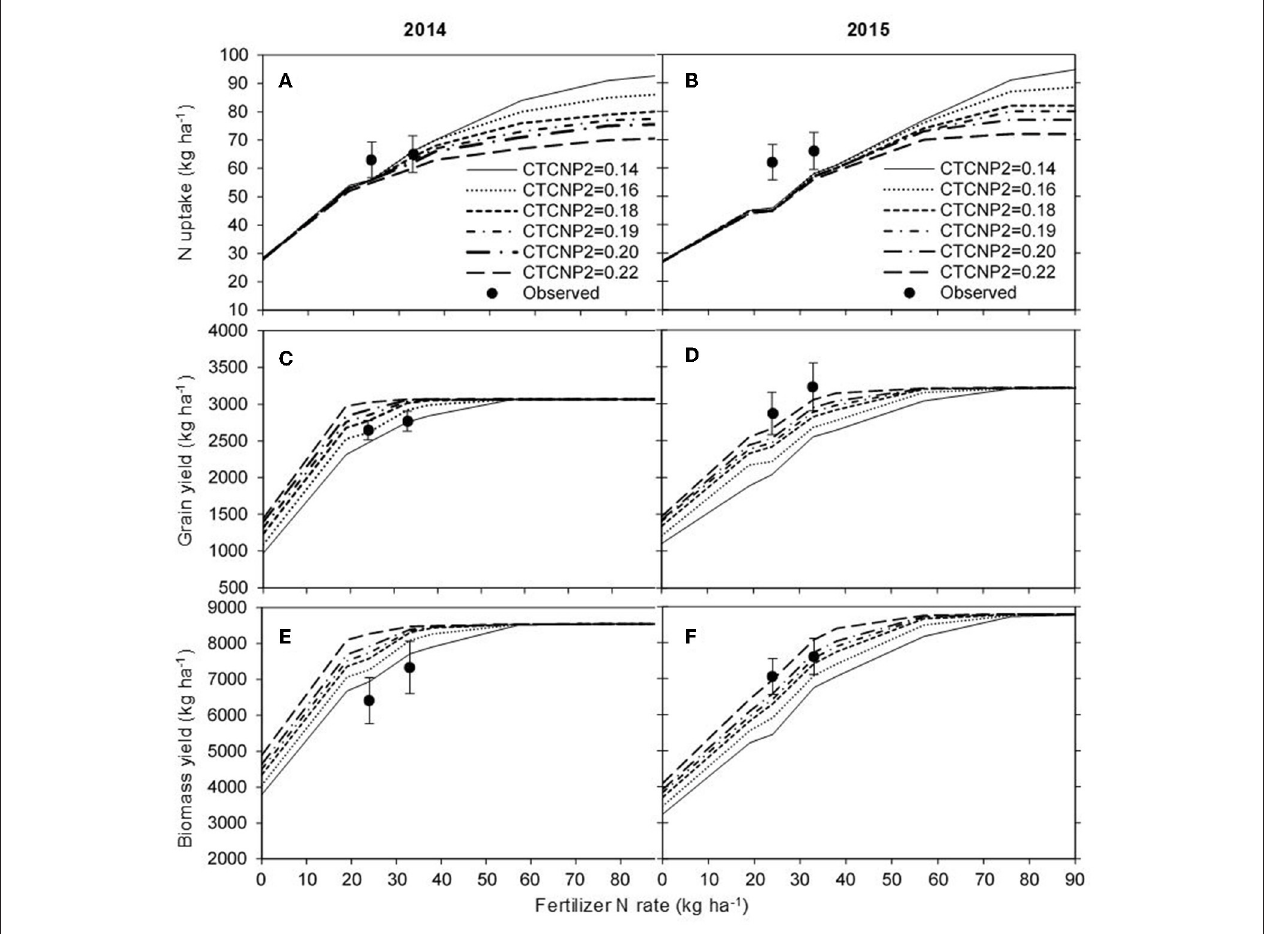
FIGURE 4 | Sensitivity of maize aboveground N uptake (A,B) , grain yield (C,D) and aboveground biomass (E,F) at harvest to incremental changes in the N stress coefficient from 0 to 90kg ha − 1 of N fertilizer rates using the hole-placement method at 0.10m depth in 2014 (A,C,E) and 2015 (B,D,F) . Error bars denote standard deviation ( n = 3) for the two microdosing rates without manure (NM-MD1 and